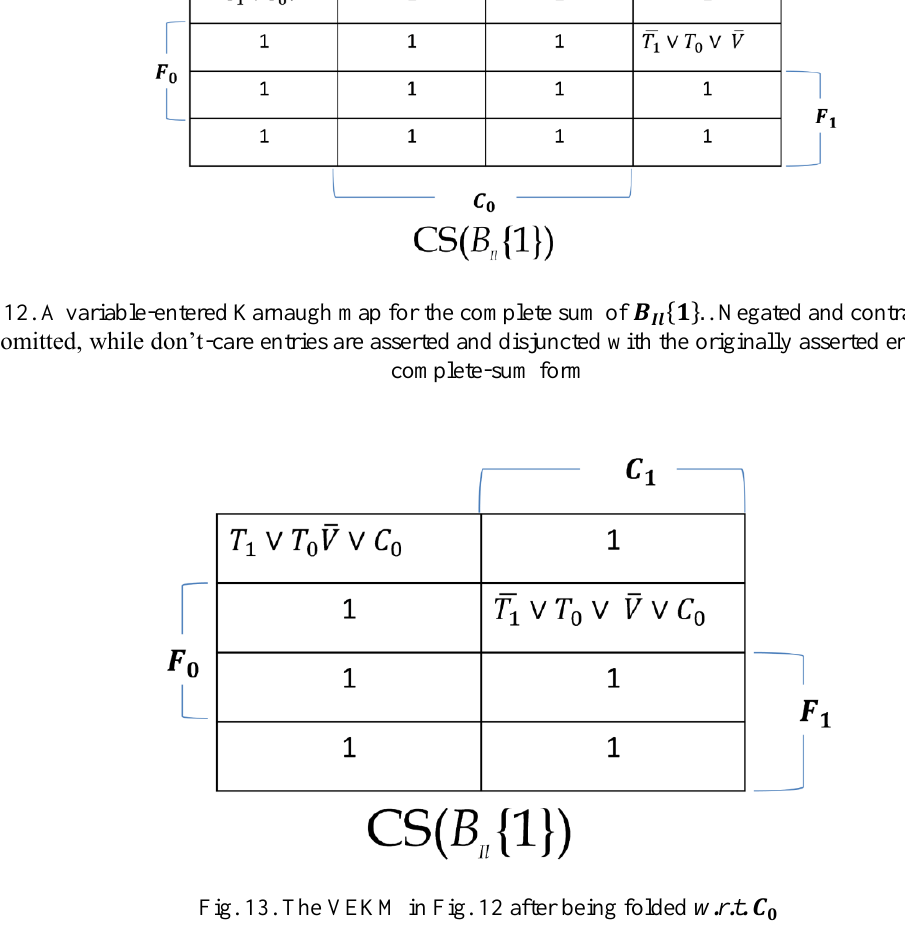
Fig. 13. The VEKM in Fig. 12 after being folded w.r.t. 𝑪